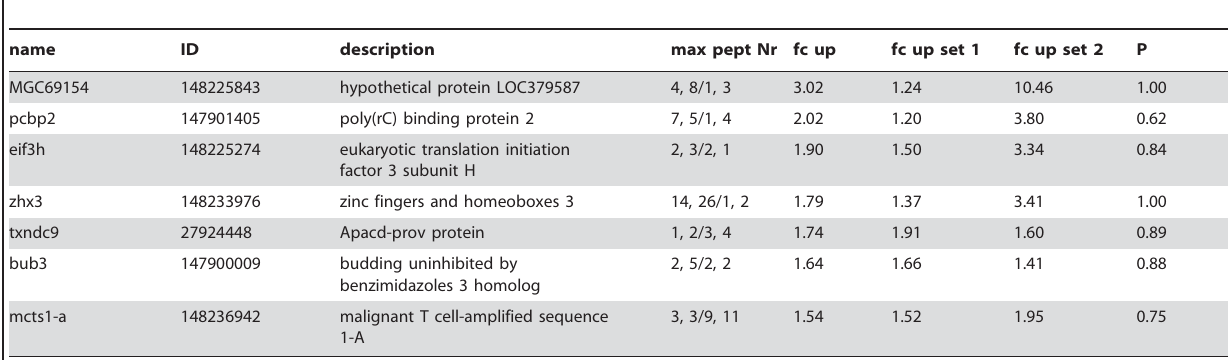
Table 2. Proteins elevated on chromatin in the absence of APC, but with unchanged dynamics of chromatin